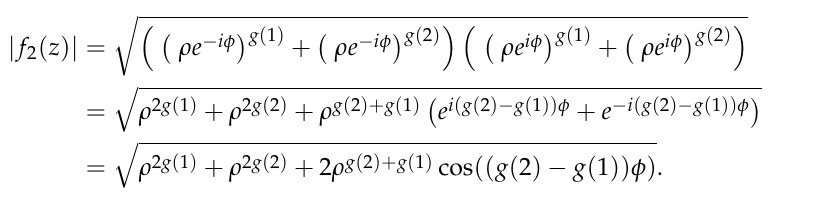
( k ) Figure 1. Contour plots of f for value of k 1–6. The contour plots are truncated at the unity level 16 ( k ) ( z ) = 1). The most prominent feature of a given graph constitutes a subset f ( k ) set ( f 16 is path-connected to the origin. The complicated nature of f ( k ) < 1, that are not path-connected to the origin. These appear adjacent to the natural f 16